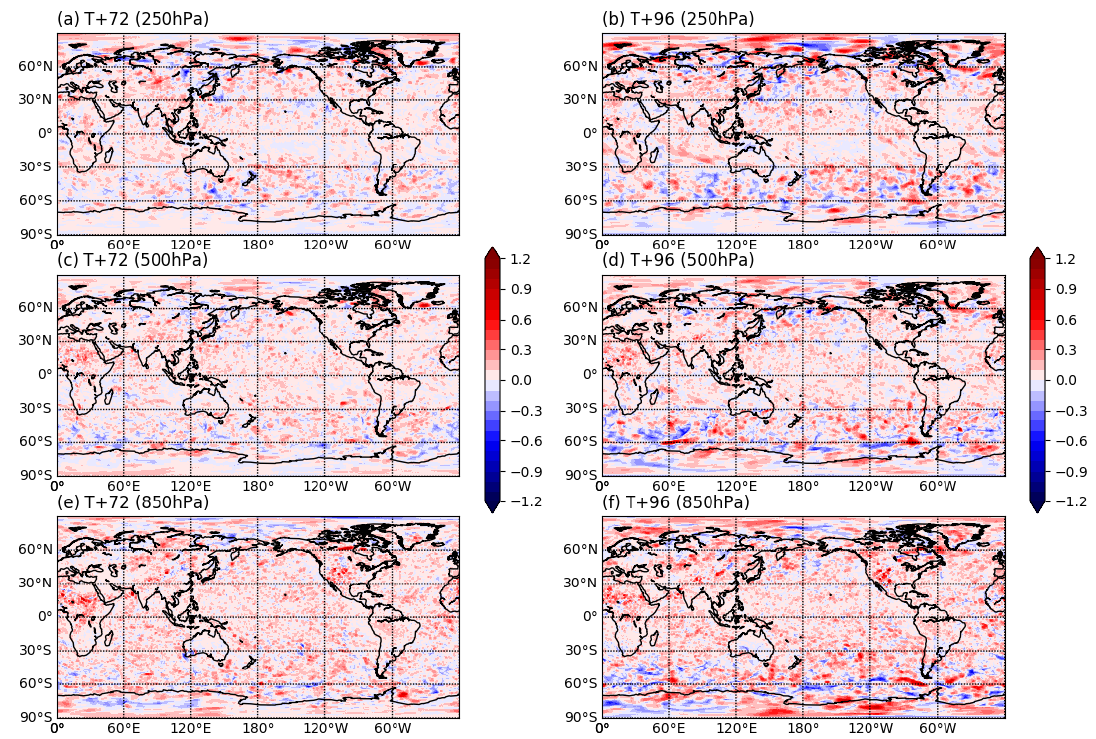
Figure 12. Global map of the mean difference of RMSE of ( a , b ) 250 hPa, ( c , d ) 500 hPa, and ( e , f ) 850 hPa temperature at ( a , c , e ) T+72 and ( b , d , f ) T+96 forecast hours between the latency_20m run and the control run.